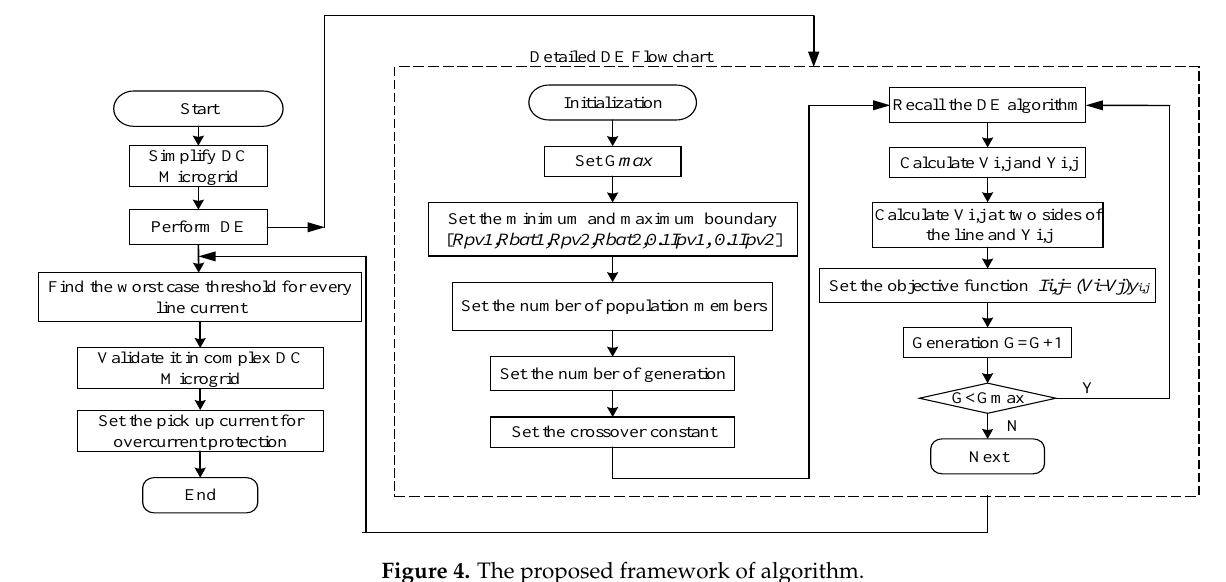
Figure 4. The proposed framework of algorithm.